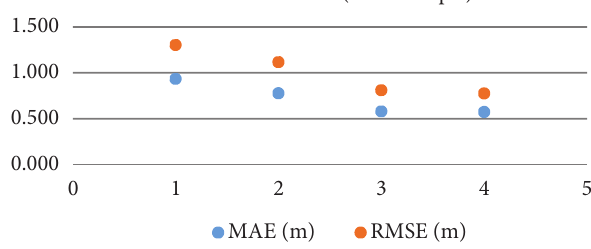
Figure 5. Error chart of the four interpolation methods for 14047 sample points